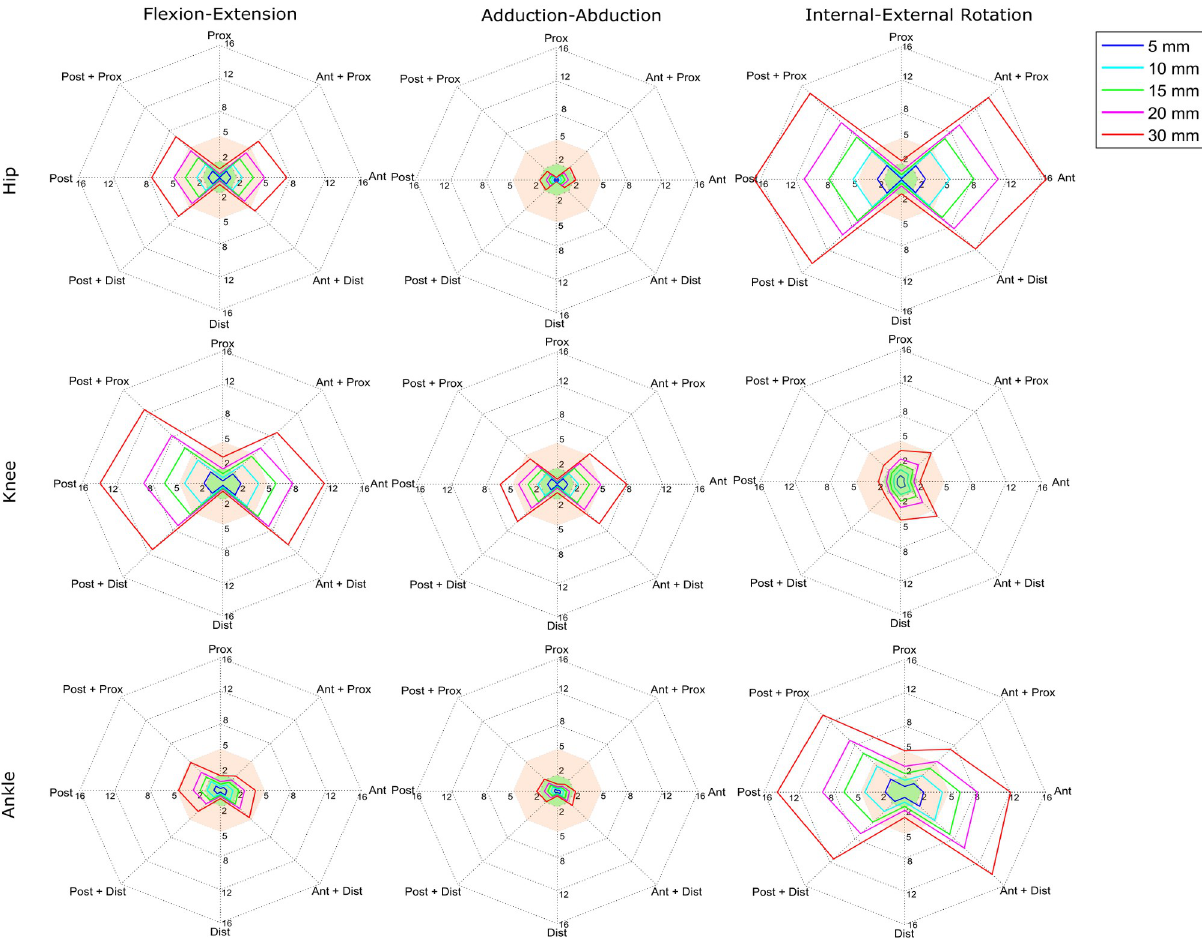
Fig 2. Impact of KNE marker misplacement on kinematics. Polar plot representing mean RMSD between marker misplacement and the original position of the overall population of participants respective to each magnitude and direction of misplacement. Green and orange area represents the thresholds of < 2˚ (Optimal) and < 5˚ (Acceptable)